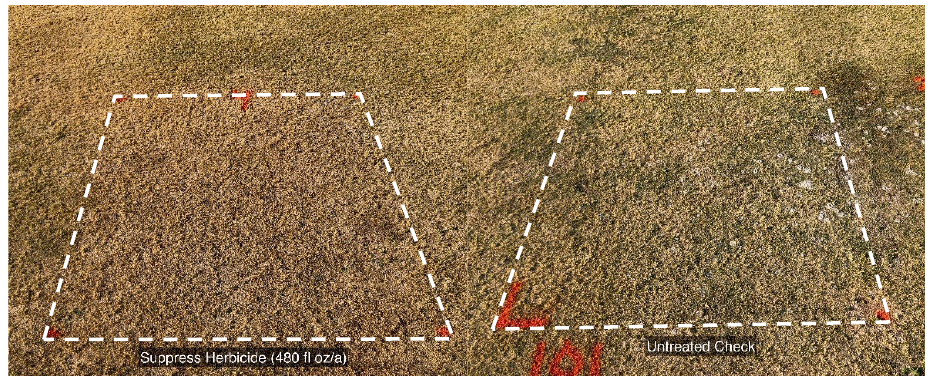
Figure 2. Suppress herbicide (480 fl oz/a) and untreated check one week after treatment (WAT) (Year 1).